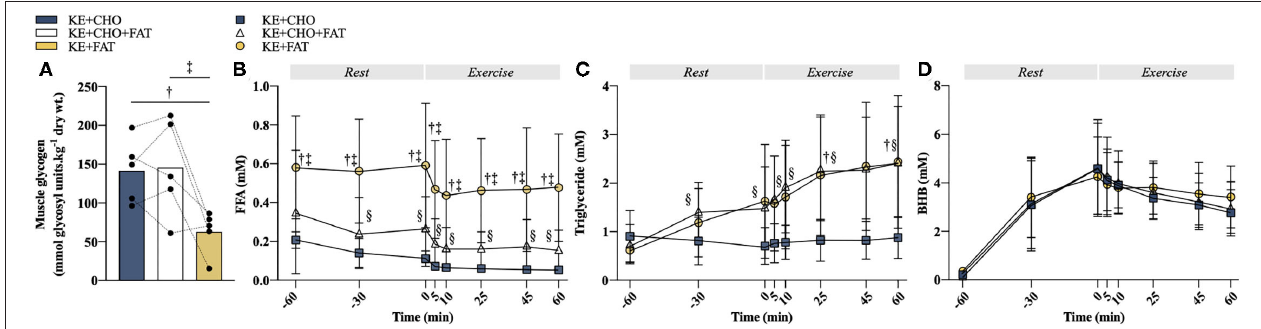
FIGURE 2 | Substrate manipulations. (A) Pre-exercise intramuscular glycogen (IMGLY). (B) Plasma free fatty acid (FFA) concentration at rest and during exercise. (C) Plasma triglyceride concentration at rest and during exercise. (D) Blood β HB concentration at rest and during exercise. Significant post-hoc comparisons: † = ketone